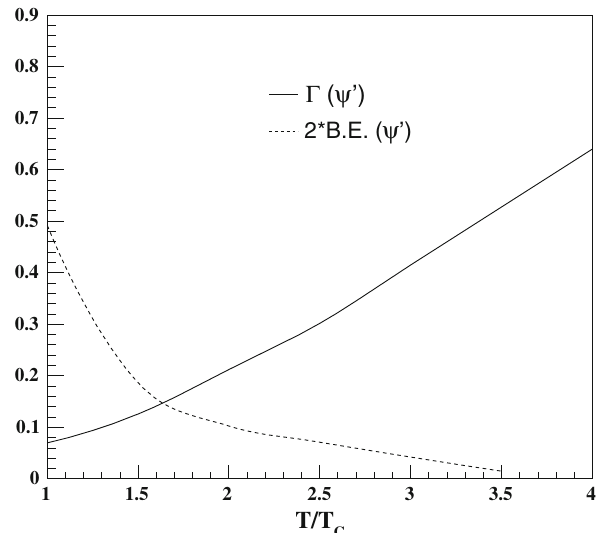
Fig. 15 Comparison of decay width of J /ψ and ϒ( 1 S )